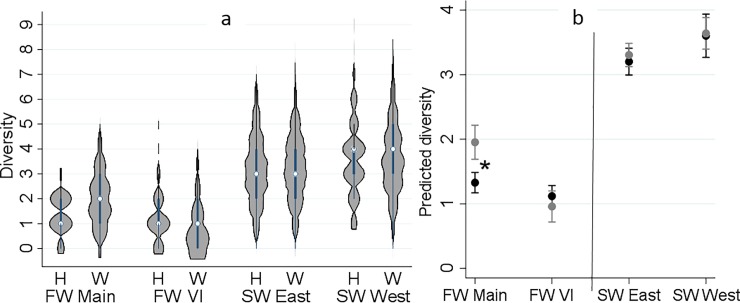
Distribution of the diversity of infectious agents detected in 2,655 juvenile Coho salmon by sampling region and origin (H: hatchery and W: wild) on left side, and the interaction plot for the results of the Poisson regression model, indicating predicted number of detected infectious agents (Y axis) by sampling region and origin (black: hatchery and grey: wild) on right side. Sampling regions: 1) freshwater-Mainland; 2) freshwater-Vancouver Island (VI); 3) saltwater-east coast of VI; and 4) saltwater-west coast of VI. *Statistical comparisons (Bonferroni groups) for predicted diversity between hatchery and wild were only significant in freshwater-Mainland (P < 0.001).